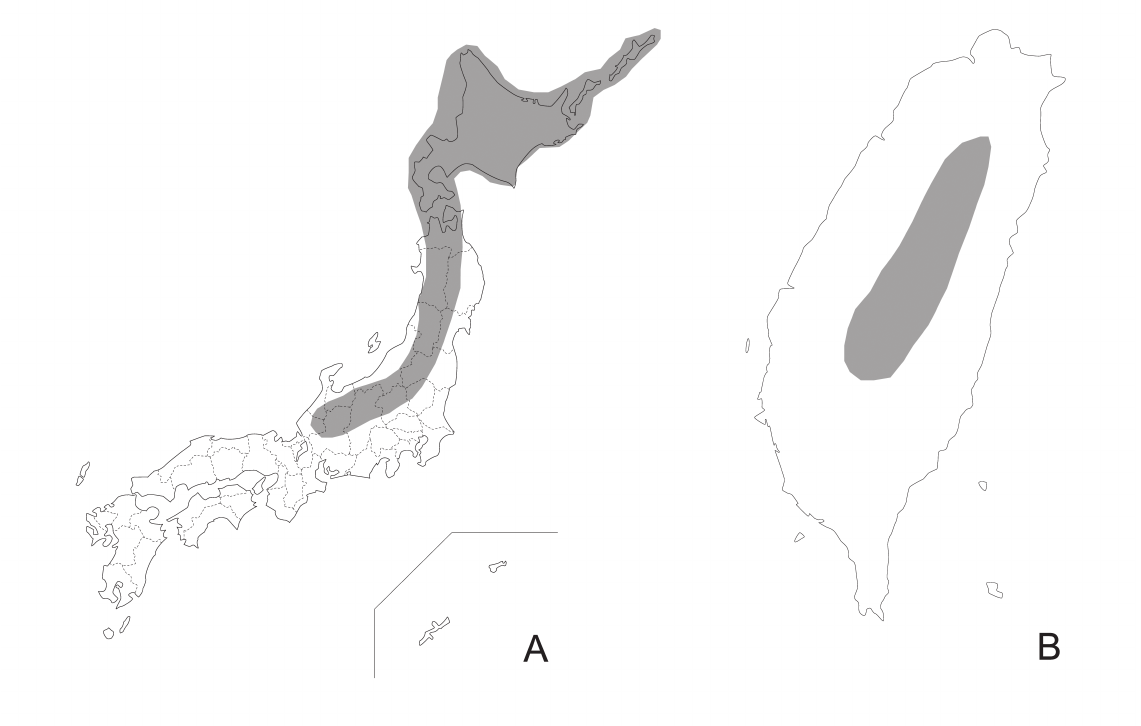
Fig. 19. distribution maps. A . Lasioglossum ( Dialictus ) problematicum (Blüthgen, 1923) in Japan. B . Lasioglossum ( Dialictus ) alishanense Murao sp.